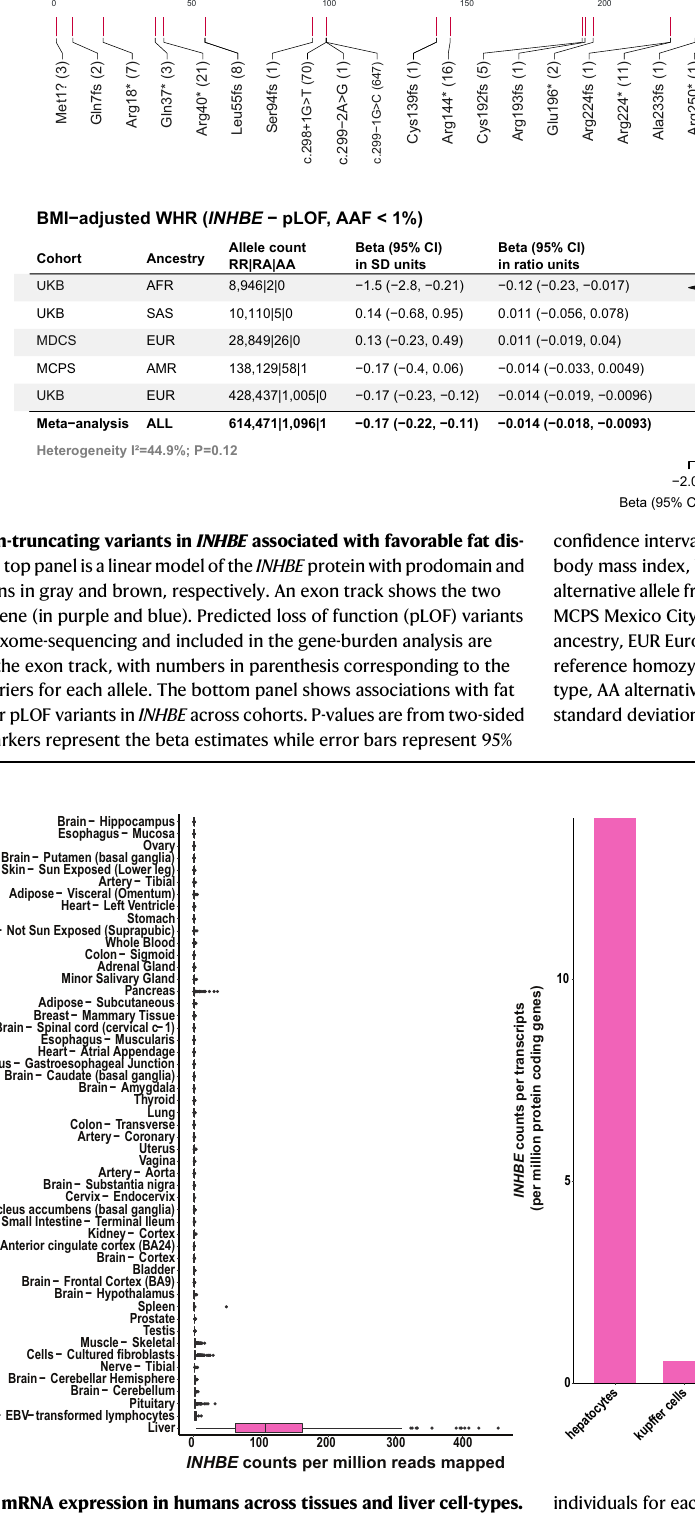
individuals for each tissue 107 . The right panel shows normalized cell-type speci fi c expression within liver in counts per transcripts per million protein coding genes (pTPM) from the Human Protein Atlas (HPA) 108